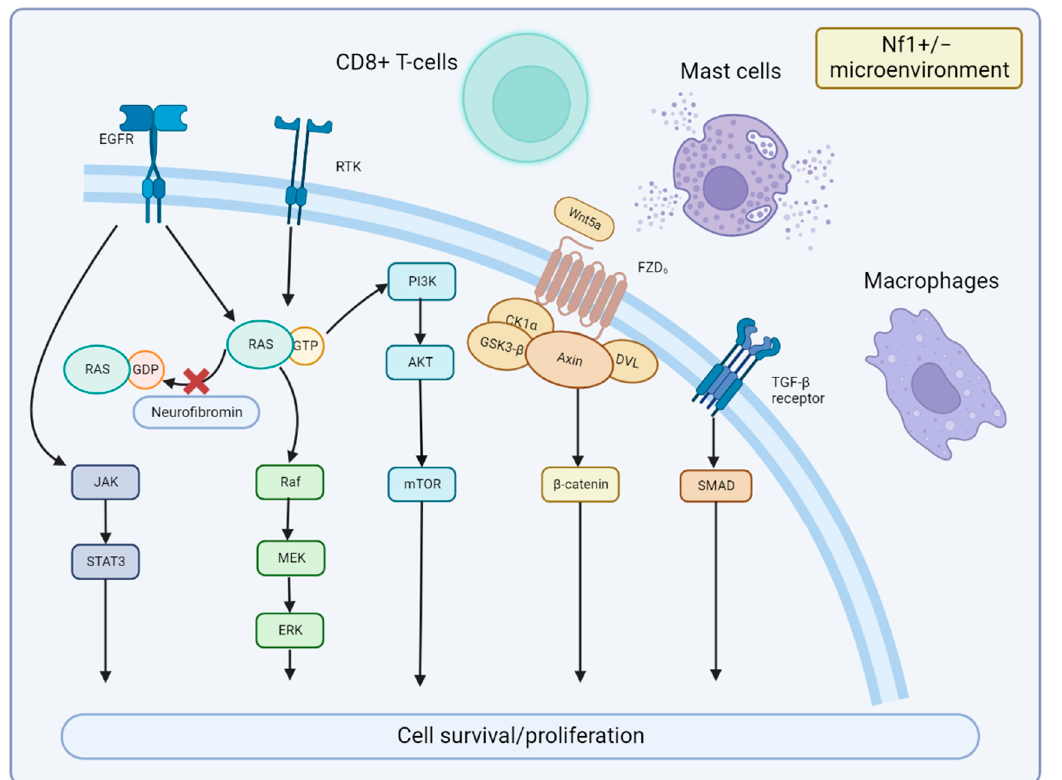
Figure 4. Signaling Pathways and Microenvironment of MPNST. Neurofibromin encoded by NF1 is lost in MPNST, which leads to the continued activation of RAS signaling and downstream MEK and mTOR effectors. JAK/STAT3 and Wnt/ β -catenin signaling are also involved in MPNST development. Nf1+/ − microenvironment of mast cells, CD8+ T cells, and macrophages can promote MPNST growth with cytokines or immune dysfunction.